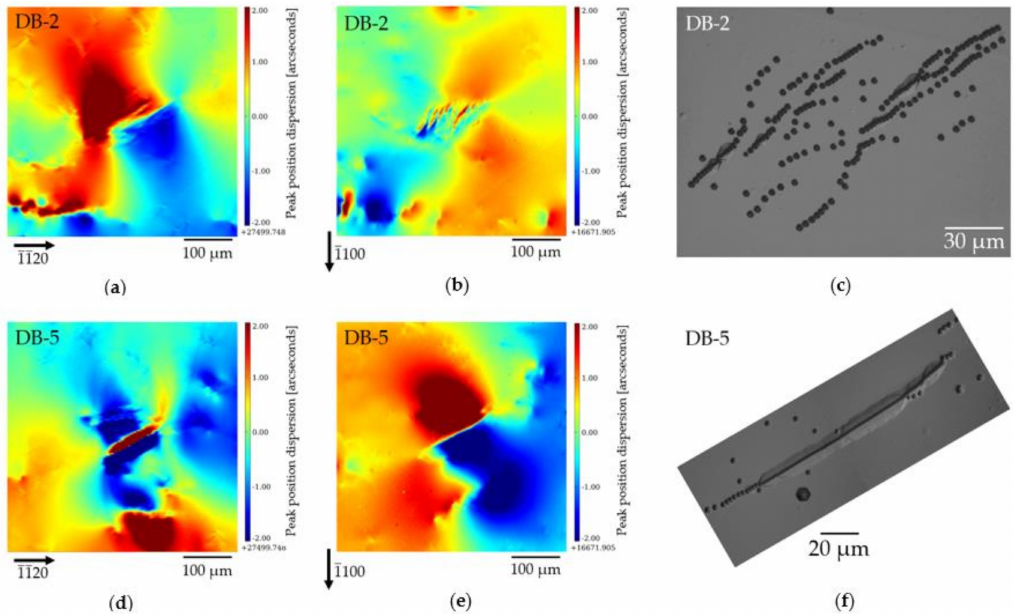
Figure 14. Magnified 1120 and 1100 PPOS map images of two DBs (indicated as 2 and 5 in, e.g., Figures 3b and 6a) of the HCD-A cluster, together with the corresponding DSE images (a highly magnified image of the etched DB 5 (Figure 14f) is shown in Appendix B, Figure A4). The explanation for the individual figures is given in the text. ( a ) 1120 reflection PPOS map of DB-2, ( b ) 1100 reflection PPOS map of DB-2, ( c ) DSE image of DB-2, ( d ) 1120 reflection PPOS map of DB-5, ( e ) 1100 reflection PPOS map of DB-5, ( f ) DSE image of DB-5.